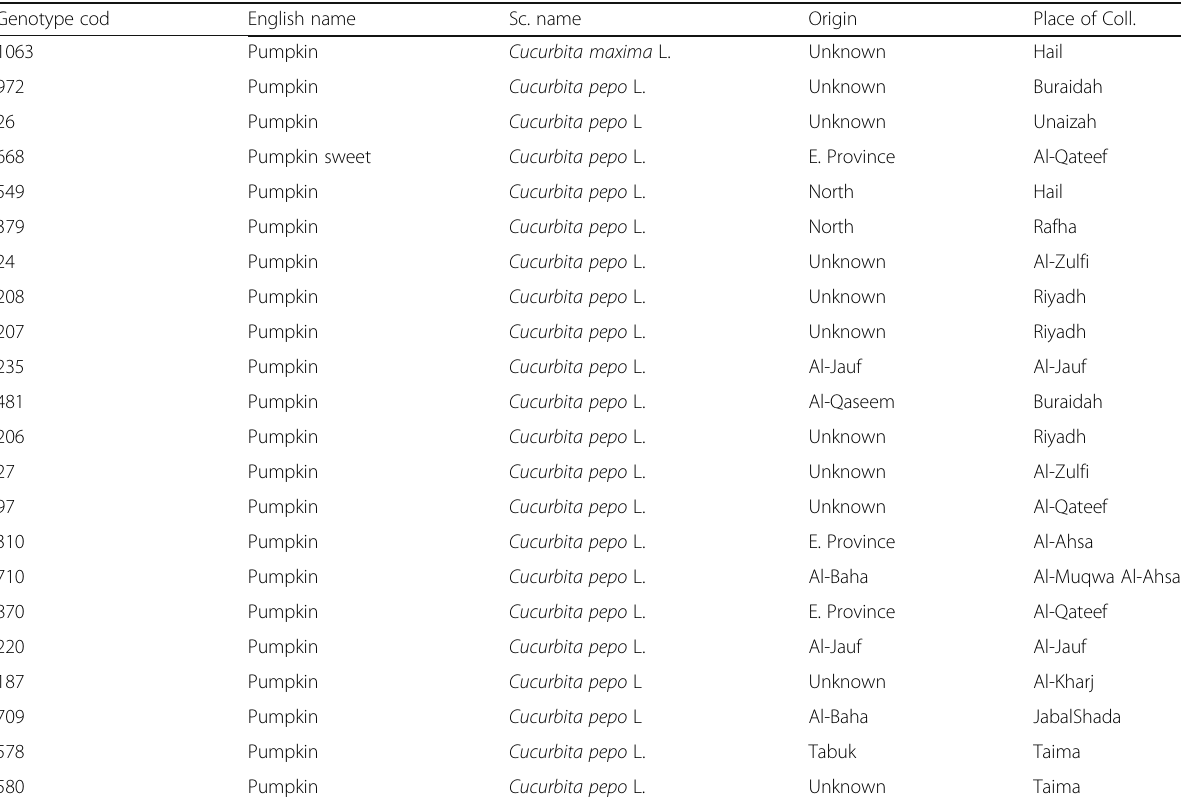
Table 1 Genotype cod, English Name, Sc. name, and country of origin of 21 genotypes of Cucurbita pepo L. and one Cucurbita moschata